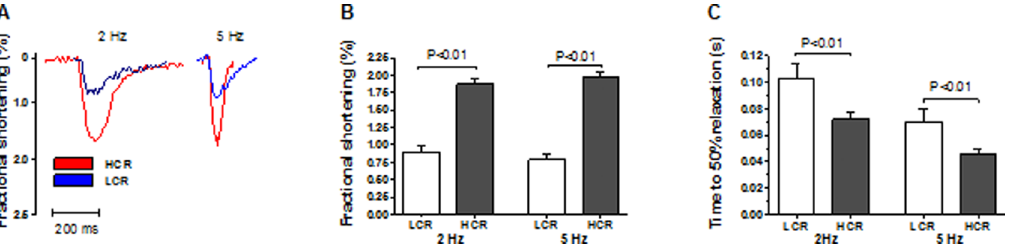
Figure 2. Analysis of atrial myocyte function. A, Exemplary tracings of atrial myocyte function in Low Capacity Runner (LCR)- compared to High Capacity Runner (HCR) rats display a deteriorated viability in LCR rats both at systolic and diastolic properties. B, Fractional shortening was depressed at 2 and 5 Hz stimulation in LCR rats and, C, Time to 50% relaxation was increased LCR rats. n=5 animals, n=4 2 6 cells from each animal. Data are presented as mean 6